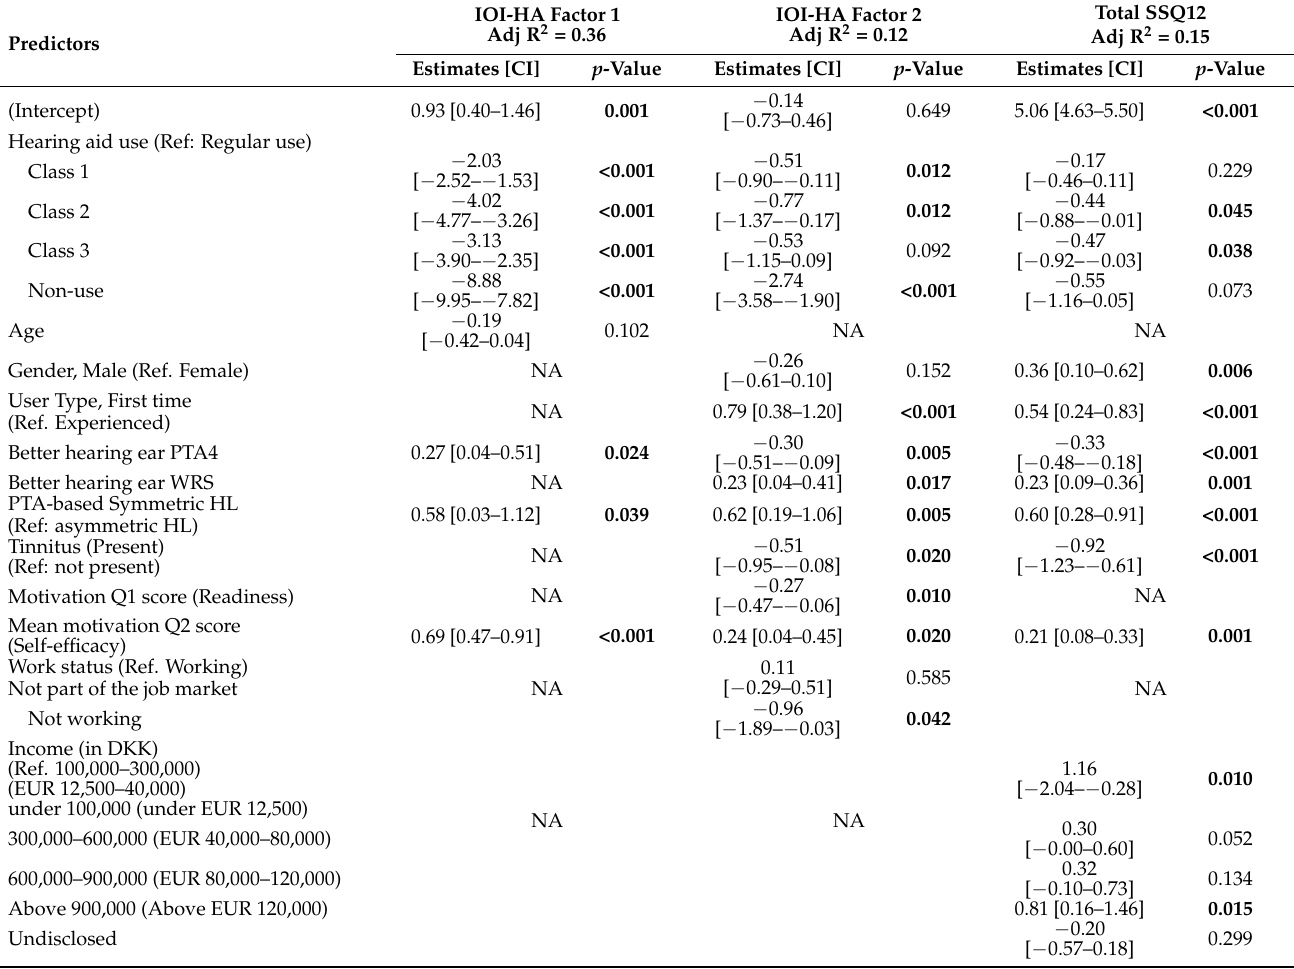
Table 2. Stepwise multiple linear regression analysis of two IOI-HA Factor scores and total SSQ12 scores for situations where HA users always took off their hearing